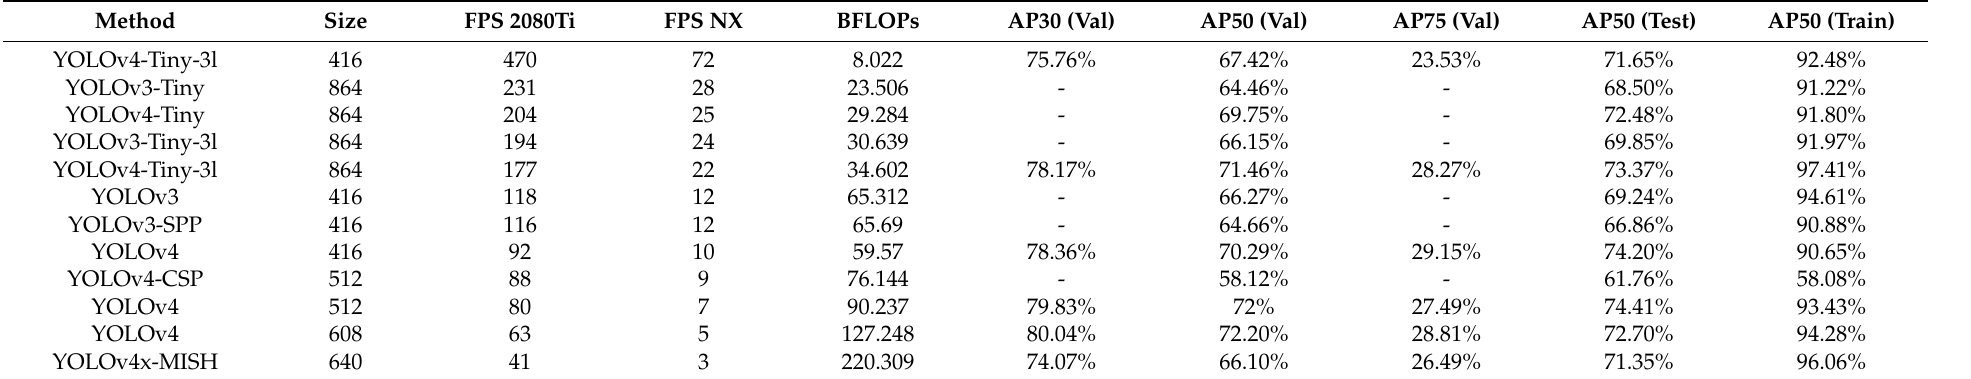
Table 2. Comparison of state-of-the-art object detectors on the HAIDA trash dataset.